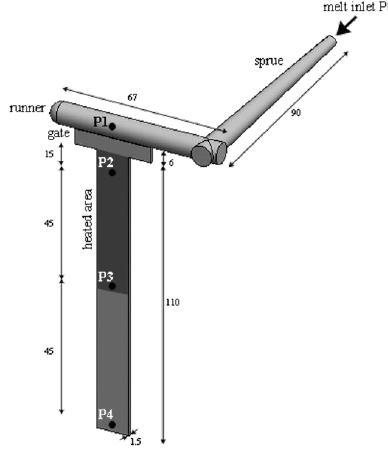
Figure 1. Cavity adopted for the injection molding experiments. The dimensions are referred to